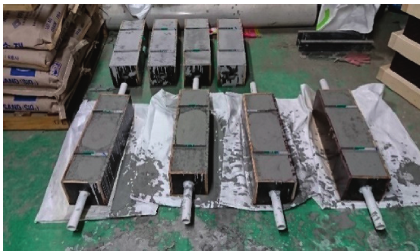
Figure 13: Curing process of concrete